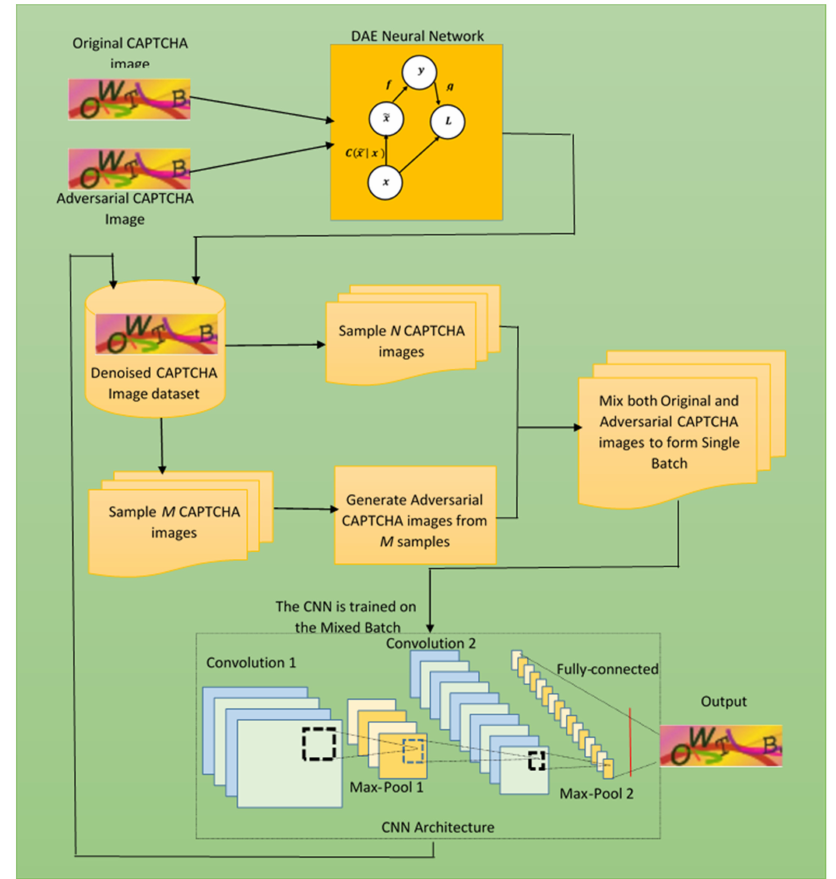
Figure 11. The workflow of the proposed robust deep learning model for adversarial text-based CAPTCHA security